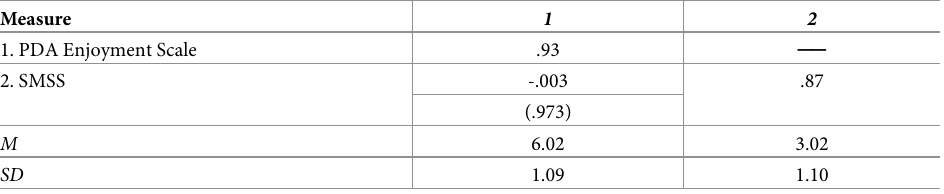
Table 3. Summary of correlations, reliabilities, means, and standard deviations for scores on scales for PDA and minority stress in Study 2. Measure